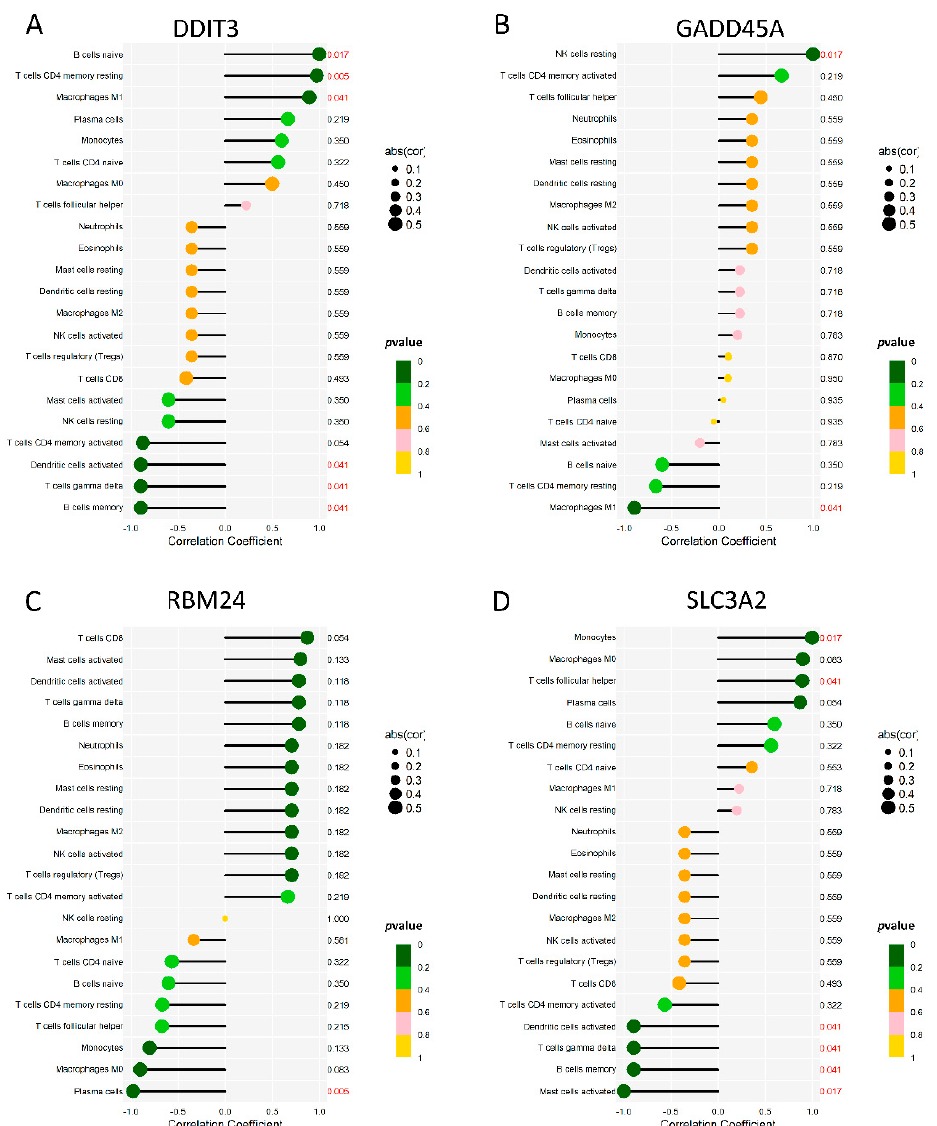
Figure 7. The immune correlation between 4 genes and 22 immune cells. ( A ) A lollipop map of DDIT3 and 22 immune cells. ( B ) A lollipop map of GADD45A and 22 immune cells. ( C ) A lollipop map of RBM24 and 22 immune cells. ( D ) A lollipop map of SLC3A2 and 22 immune cells.